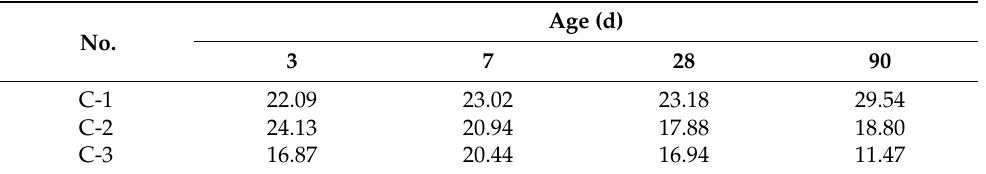
Table 8. Growth rate of compressive strength of concrete (%).